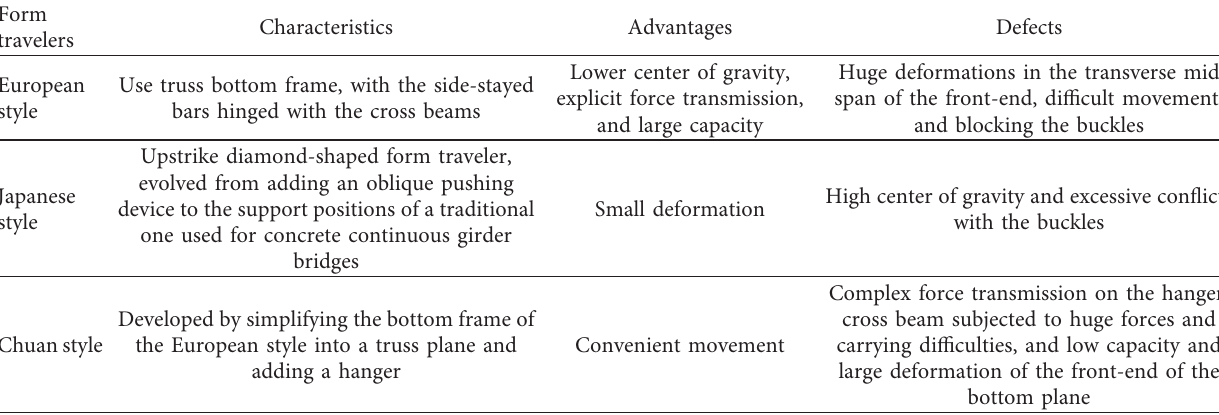
Table 1: Comparisons among different mainstream form